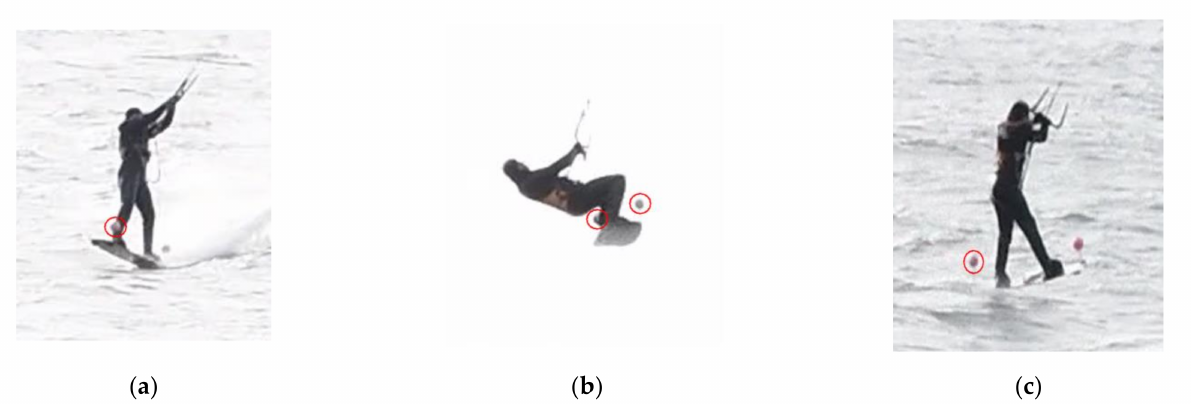
Figure 5. For each of the 20 jumps, ( a ) one spherical target was measured on five images before leaving the water surface; ( b ) both targets were measured on 15–20 images nearest to the highest position in the air, and ( c ) one target was measured on the first image after re-contact with the water